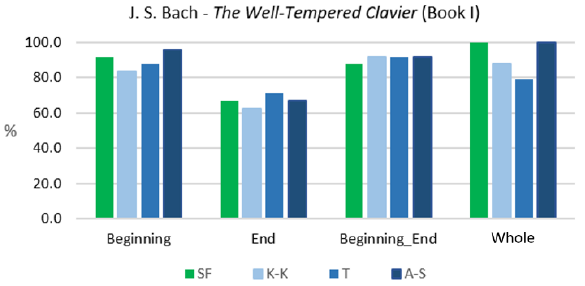
Figure 8. The key-finding efficacies obtained for the preludes of J. S. Bach, from The Well-Tempered Clavier collection (Book I); the analyzed samples represented using the multiplicities of occurrences of individual pitch-classes.